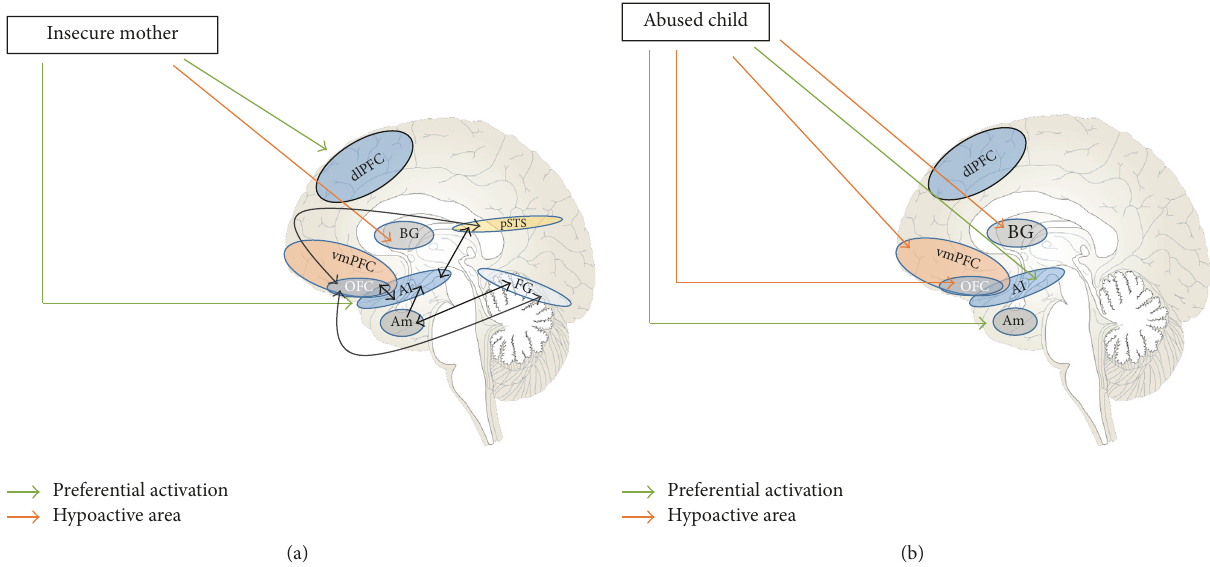
Figure 2: Demonstration of the transgenerational transmission of a neurocircuitry template of misattunement. (a) demonstrates the pattern observed in the insecure/misattuned mother. When looking at her child, a mother will quickly access a complex interconnected network, including facial identification areas (FG) and empathic attunement areas (vmPFC and pSTS). Importantly, in addition to these areas, there is connection with areas of the brain which are involved with immediately valenced reactions (amygdala), reward-risk considerations (OFC), and feelings of empathy versus disgust and shame (insula). Thus, there is a prominent subcortical input which will inform whether approaching one’s child is something considered desirable or potentially dangerous. The misattuned mother will preferentially activate cognitivecontrolareas(dlPFC)asopposedtothemoreempathicallyattunedvmPFC;inaddition,thereisheightenedactivationoftheanterior insula (associated with social pain and unfairness)and lessened activation of areas of theVS (associated with reward toexternal stimuli).Thus, the model for avoidance of emotional attachment is engendered, and there is a corollary in this mother’s child, which is illustrated by the CNS findings in the abused child. (b) illustrates the findings seen in a child who has suffered abuse, which seem to mirror in some important ways what was seen in the mother. Hyperactivity of the amygdala and decreased volume of the hippocampus can result in highly affectively driven responses to stimuli without access to contextual data which would allow for a less polarized reaction; thus, the greater input of the amygdala will drive the OFC balance and favor the dlPFC with regard to how the environment is negotiated; hypoactivation of the vmPFC will impair one’s ability to control this amygdala response and promote fear extinction. Also, the child shows a diminished ability to see the potential positive value of rewarding stimuli due to hypoactivation of the corpus striatum, impacting how interpersonal interactions are seen, and creating a model of mistrust and negativity when dealing with other people. FG = fusiform gyrus; vmPFC = ventromedial prefrontal cortex; pSTS = posterior superior temporal sulcus; OFC = orbitofrontal cortex; dlPFC = dorsolateral prefrontal cortex; BG = basal ganglia; Am = amygdala; AI = anterior insula; HC = hippocampus. As shown in the figure, green arrows indicate greater or preferential activation, whereas orange arrows indicate the opposite. As mentioned in Figure 1, this depiction is of the medial surface of the brain; the dlPFC, portions of the OFC, pSTS, AI, and FG are located on areas of the superolateral and inferior surfaces of the cerebrum, and their representations here are